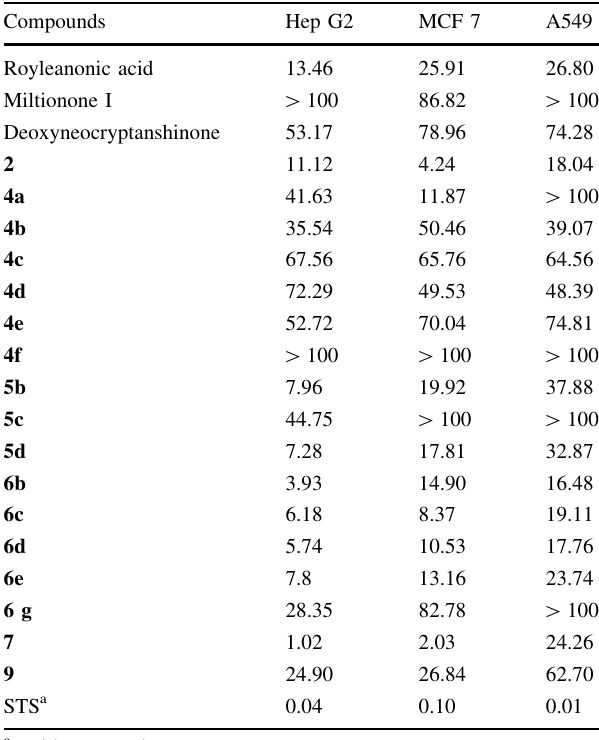
Table 1 Cytotoxicities of compounds against three cancer cell lines